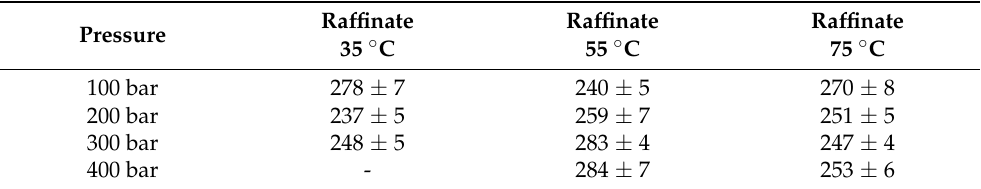
Table 5. Antioxidant capacity of the raffinate oil determined by DPPH (EC 50 expressed as mg/mg DPPH with the 95% confidence intervals).